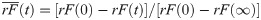
Concentration dependence of association traces of BcO binding to AV and BFl binding to SAV.(A) Corrected Fluorescence Anisotropy Concentration dependence of BcO (20 nM) binding to AV at pH 8 and 20°C, normalized as rF¯(t)=[rF(0)−rF(t)]/[rF(0)−rF(∞)]. The observed (color) curves were obtained with an AV concentration of 1040 nM (top), 520 nM (middle) and 260 nM (bottom) and the fitted curves (black lines) had halftimes of 109 ms, 229 ms and 455 ms; respectively. (B) Shows the corresponding semi-logarithmic plots of rF¯(t). (C) Normalized fluorescence change, F¯(t), concentration dependence of BFl (20 nM) binding to SAV at pH 8 and 20°C. Normalized as followed: F¯(t)=F(t)F(0)=[F(t)−rF(∞)]/[rF(0)−rF(∞)]. The observed (color) curves were acquired with SAV concentrations of 200 nM (red), 400 nM (purple) and 800 nM (orange) where the fitted curves (black lines) had halftimes of 77.3 ms, 37.7 ms and 20.6 ms; respectively. (D) Shows the corresponding semi-logarithmic plot of F¯(t).